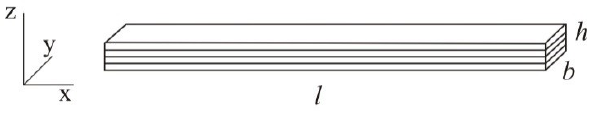
Figure 7. Orientation of the test specimen.